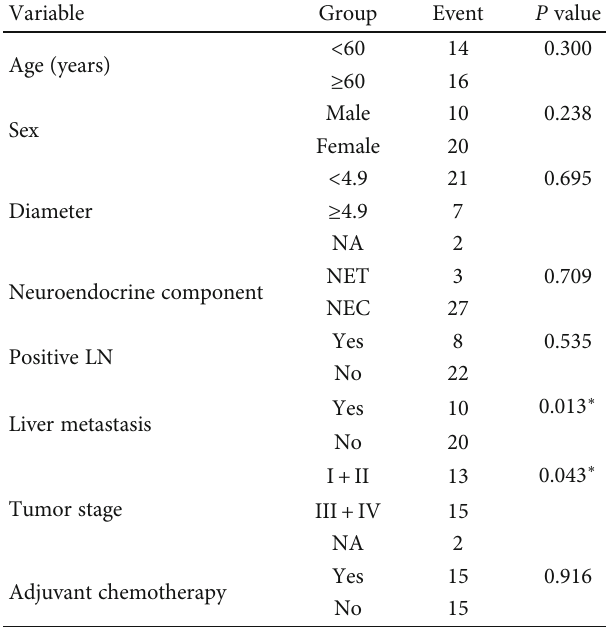
Table 5: The Kaplan-Meier analysis of the overall survival of GB- MiNENs